Question: What style of plot is this figure drawn as?
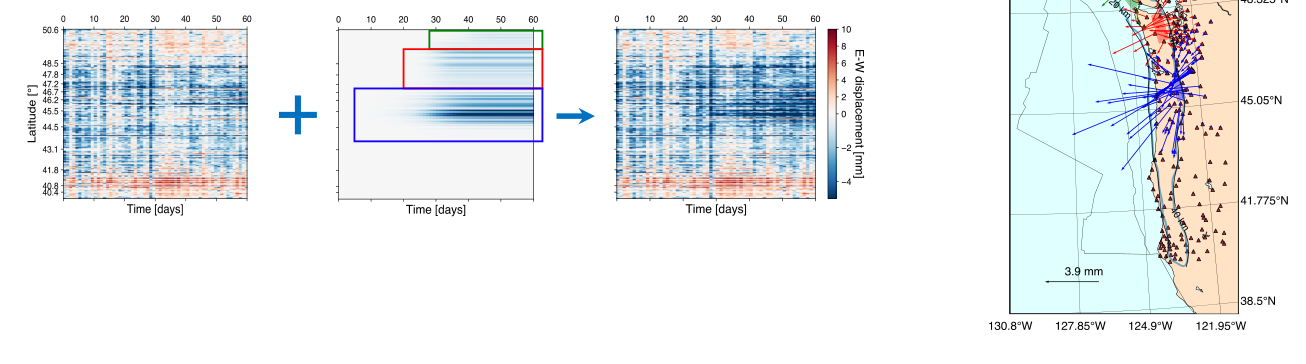
Answer: line